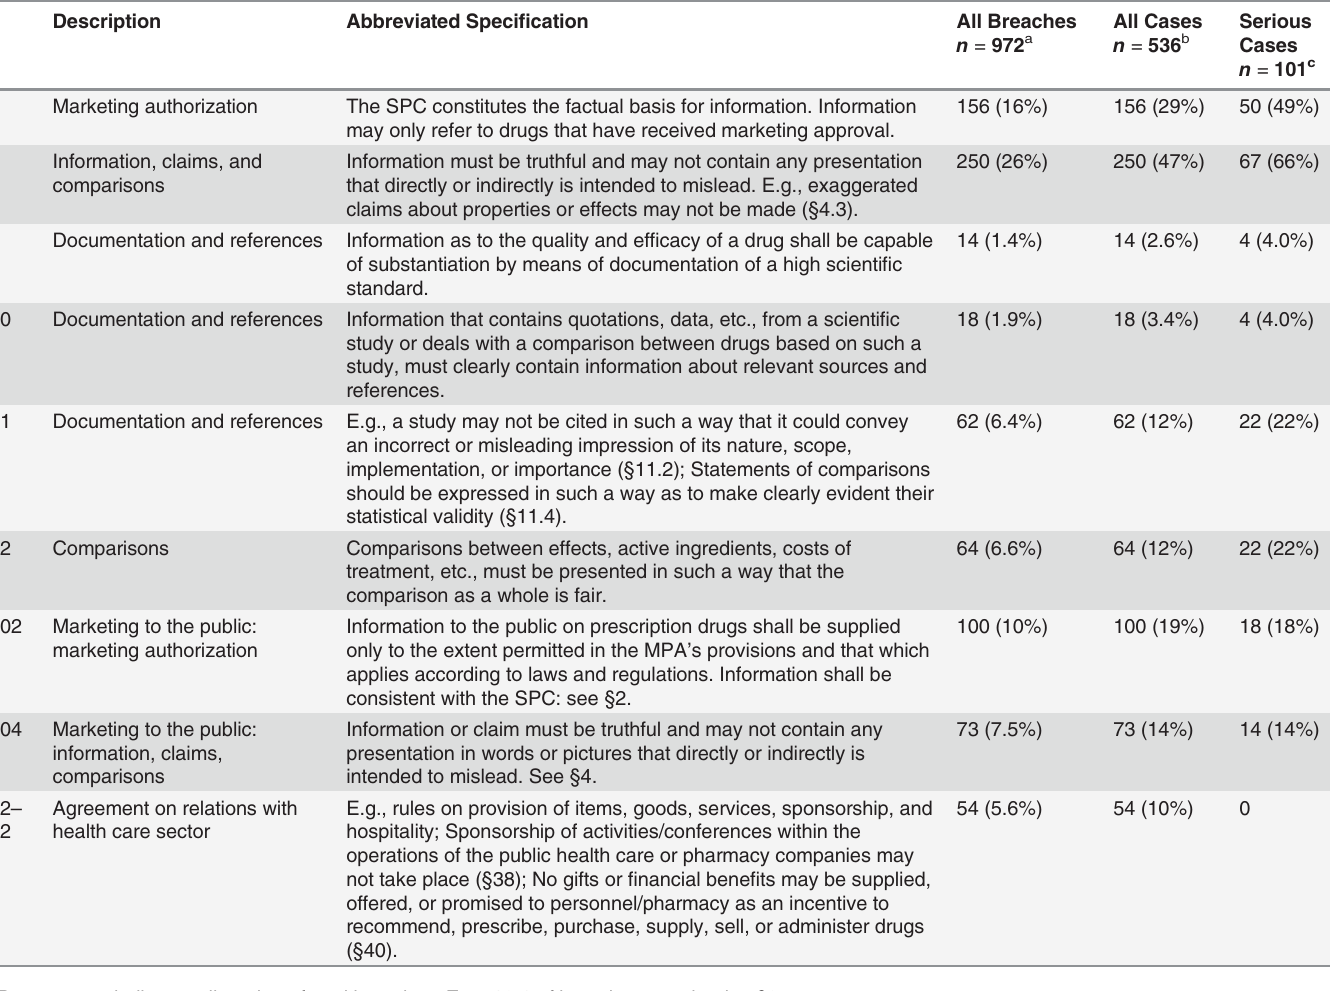
Table 4. Sweden rulings of breach of selected clauses 2004 –